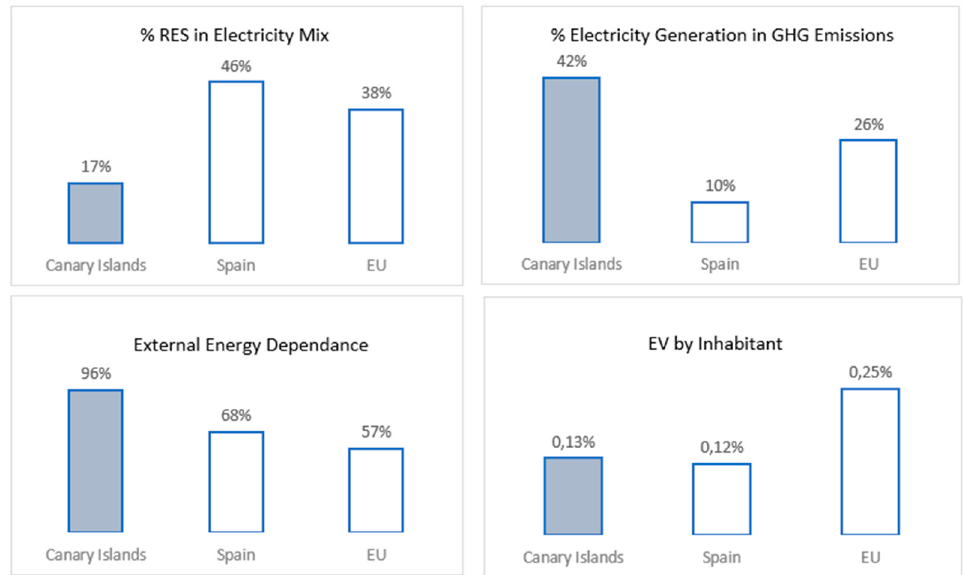
Figure 6. 2020 Data. Own elaboration sourced with the 2020 Canary Islands Yearbook , Spanish Ministry for Energy Transition, and Eurostat.